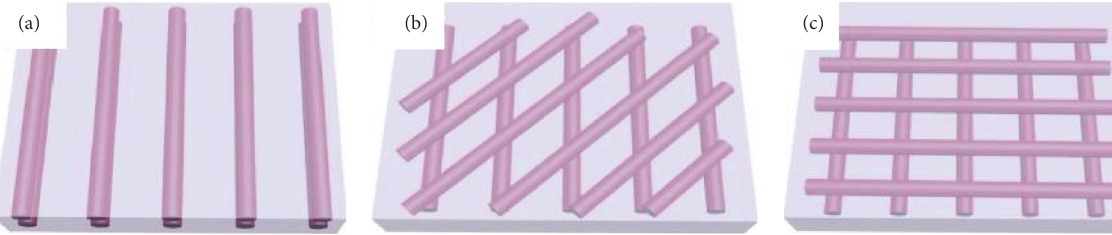
Figure 1: Schematic drawings of layer-by-layer of aligned fibers with different interlayer angles of 0 ∘ (a), 45 ∘ (b), 90 ∘ (c).